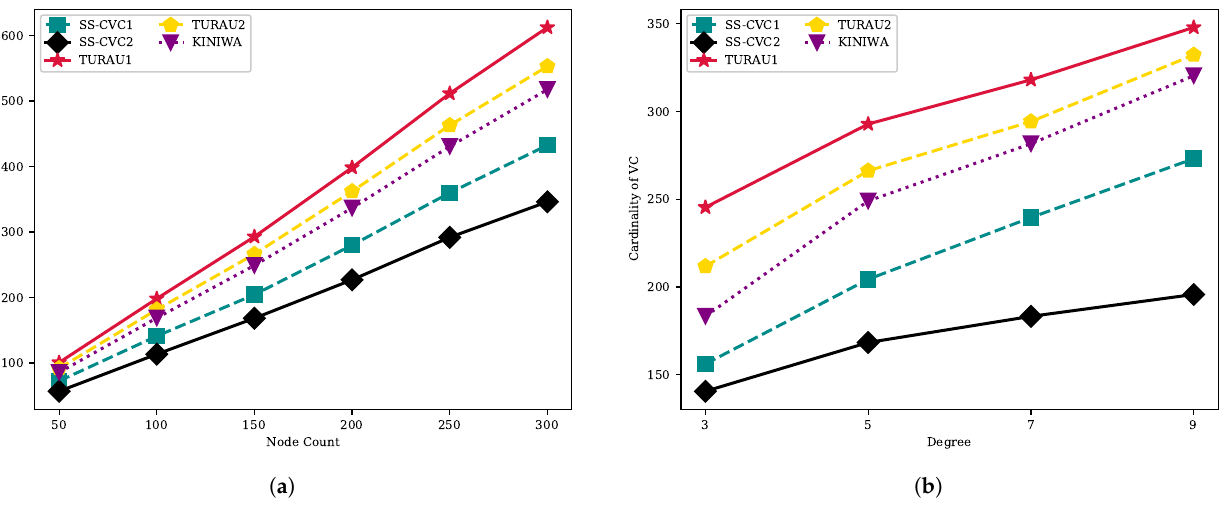
Figure 12. VC size of algorithms on the weighted networks: ( a ) VC size against node count on the fixed average degree 5; ( b ) VC size against node count on the fixed network size